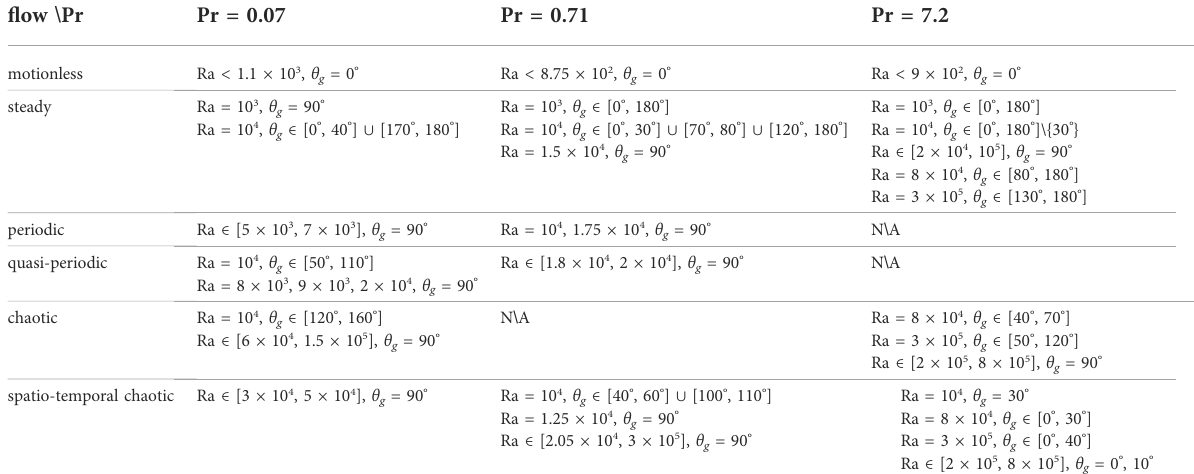
TABLE 1 Distribution of six fl ow types with Ra and θ g at Pr = 0.07, 0.71, 7.2. fl ow ∖